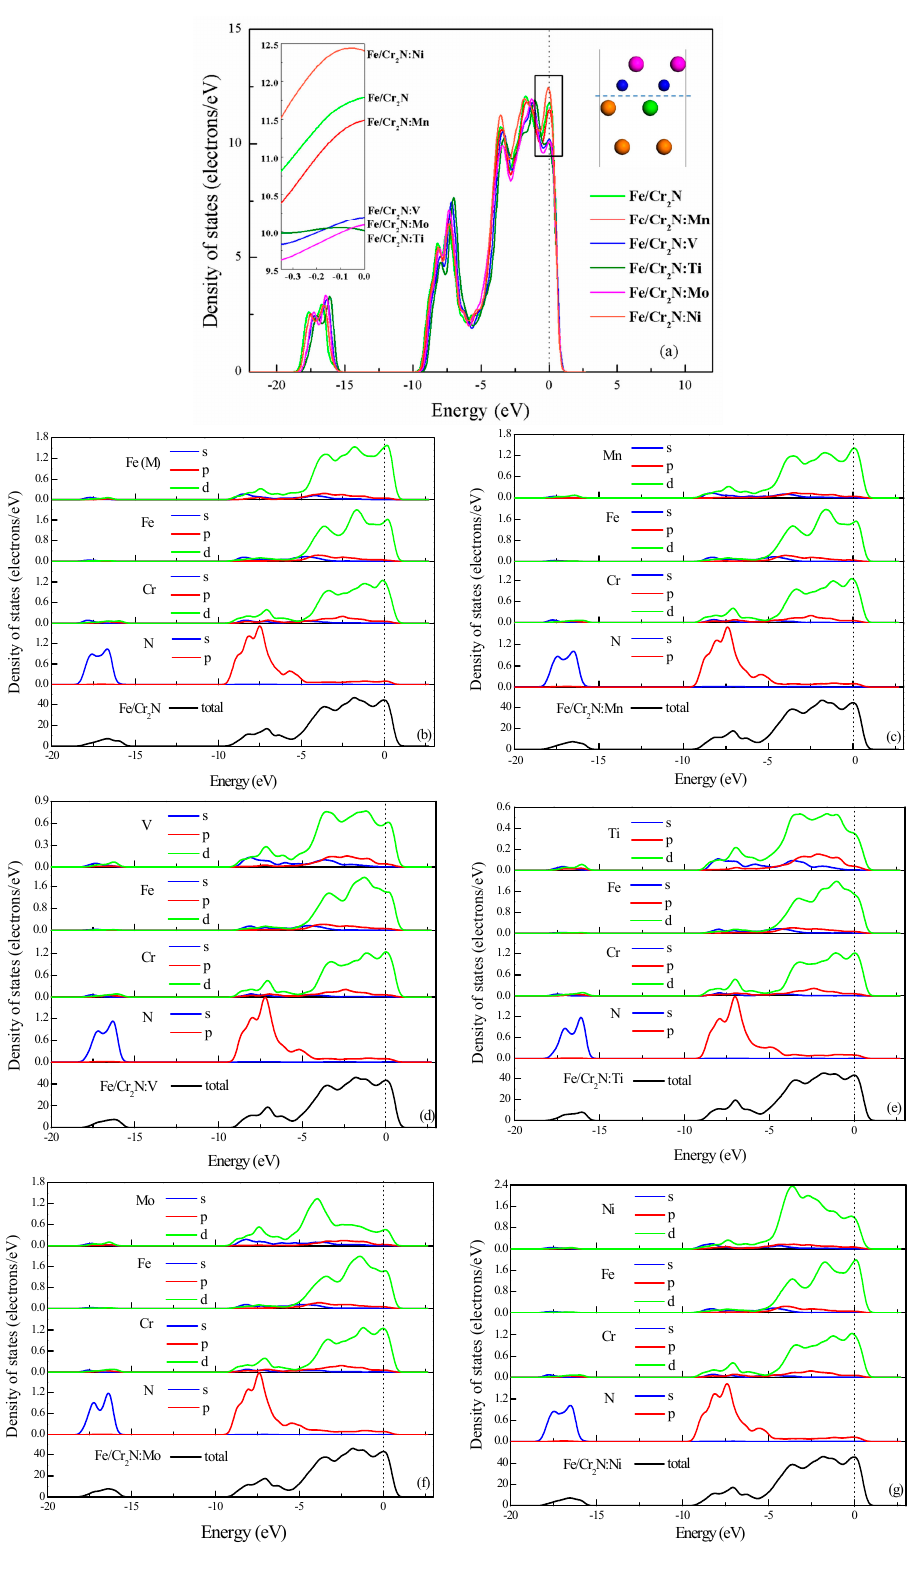
Figure 5. ( a ) Total density of states of the clean γ‐ Fe(111)/Cr 2 N(0001) interface and that after different solution atoms introduced (M = Mn, V, Ti, Mo, Ni); DOS and PDOS of different solution atoms: ( b ) clean interface; ( c ) Mn; ( d ) V; ( e ) Ti; ( f ) Mo; ( g ) Ni.